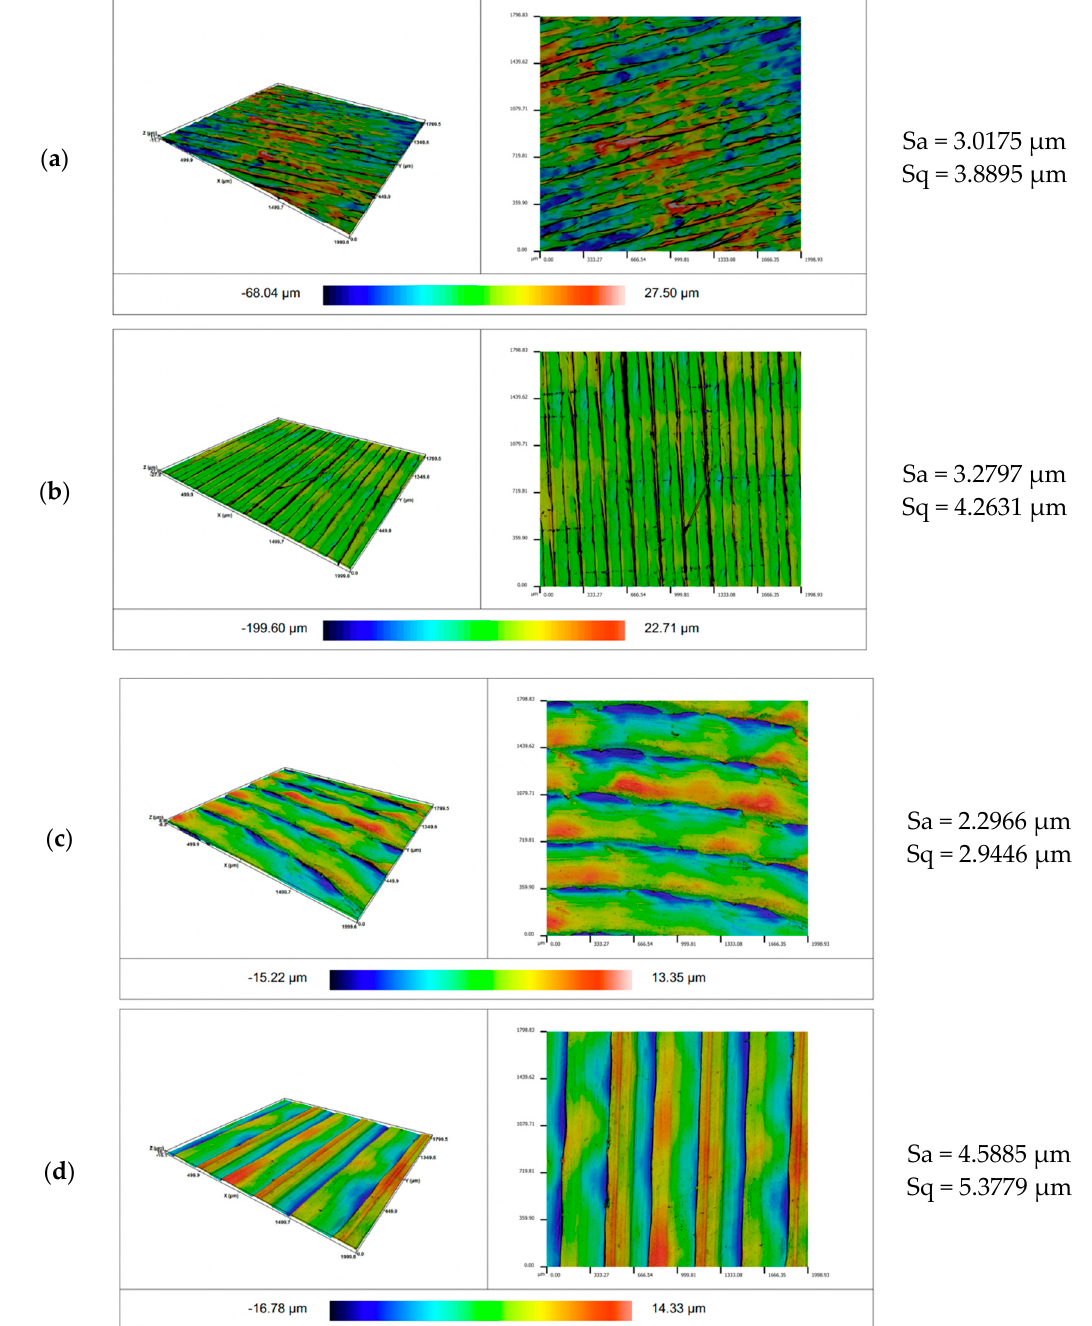
Figure 11. Isometric views of the surface roughness made with different configuration of patterns and material: ( a ) TPU circle; ( b ) TPU line; ( c ) PLA circle; and ( d ) PLA line.